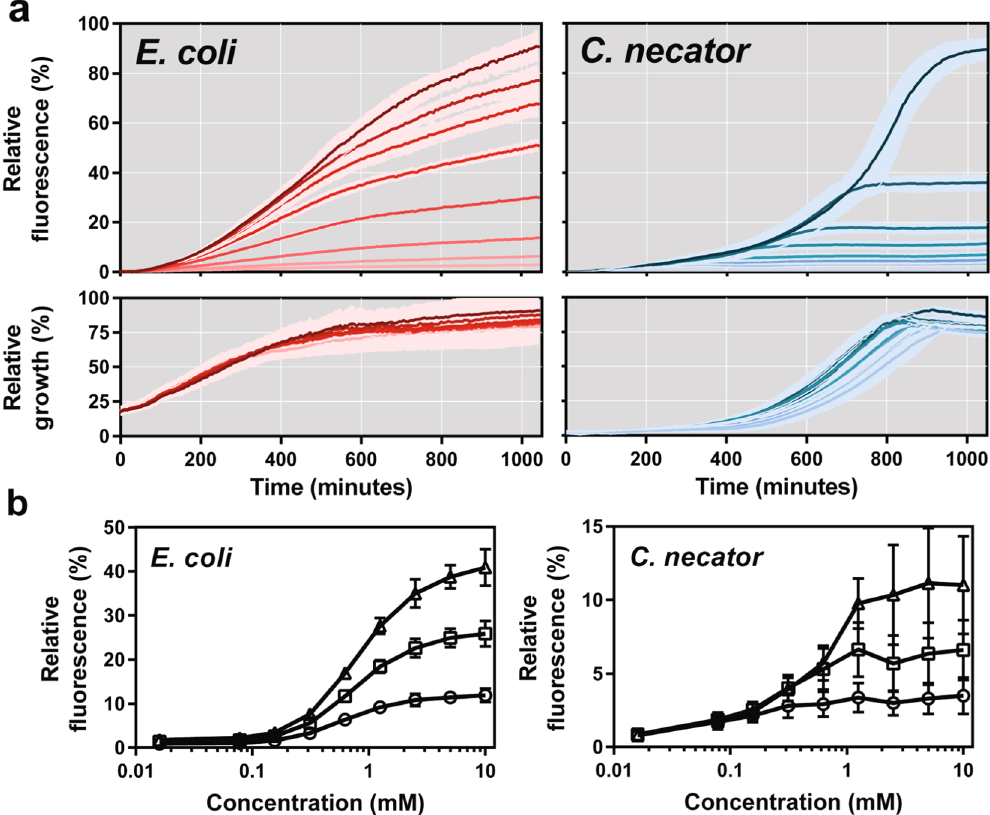
Figure 5. Induction dynamics and kinetics of the Pp HpdR/P hpdH switchable system. ( a ) Relative fluorescence and absorbance curves of E. coli MG1655 and C. necator H16 cultures harbouring the native Pp HpdR/P hpdH switchable system, pEH008. 3-HP was supplemented at time zero to the final concentrations of 10, 5, 2.5, 1.25, 0.625, 0.156, 0.016 mM and no inducer. The darker the shade of colour, the higher the level of 3-HP. The standard error of three biological replicates is illustrated as band. ( b ) Dose response curve of the Pp HpdR/ P hpdH switchable system in E. coli MG1655 and C. necator H16. It illustrates the relation between inducer concentration and fluorescence output 4 (circle), 6 (square) and 8 (triangle) hours after 3-HP addition. Inducer levels range from 0, 0.016, 0.078, 0.156, 0.313, 0.625, 1.25, 2.5, 5 and 10 mM. Error bars represent standard deviations of three biological